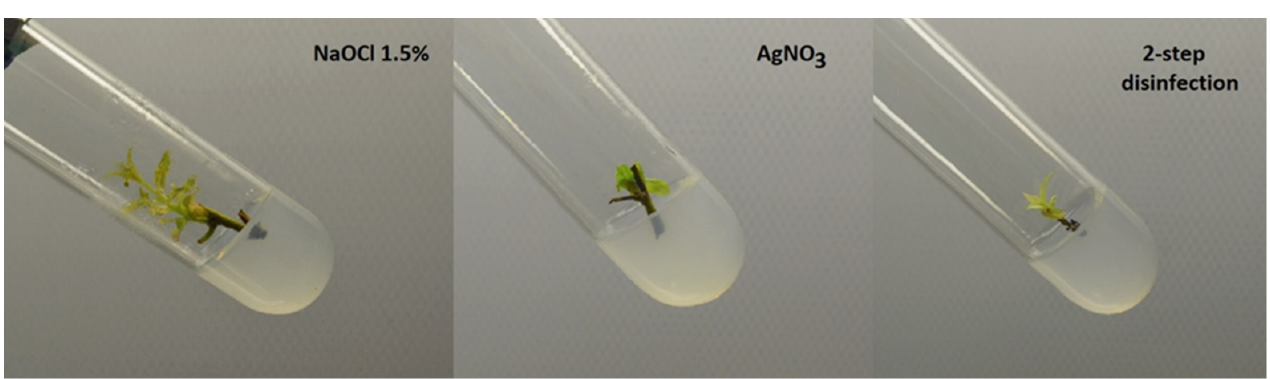
Figure 1. Shoots of Salix myrtilloides disinfected with NaOCl, AgNO 3 , or 2-step disinfection after two weeks of cultivation in vitro.